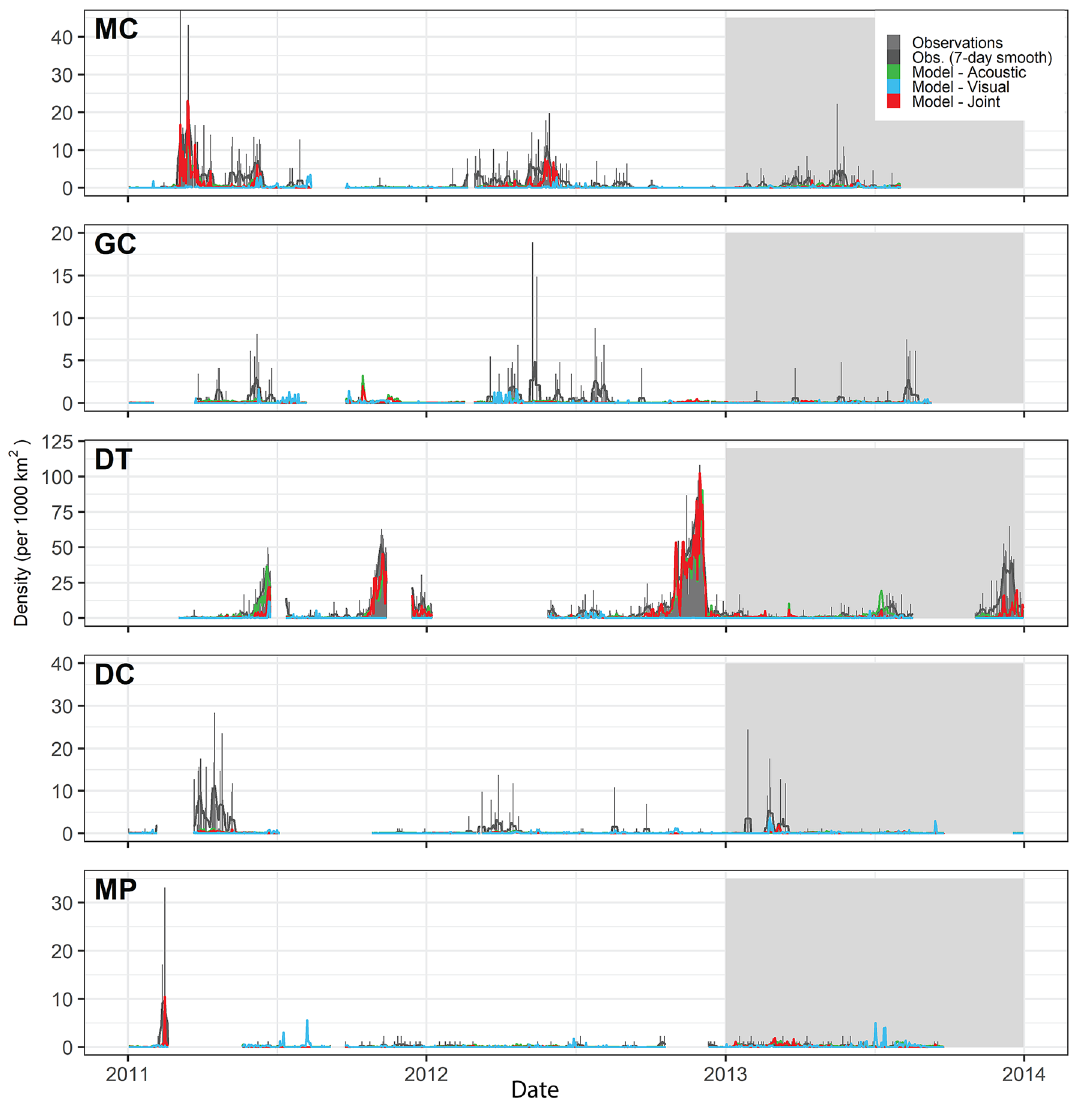
Figure 10. Time series of daily observed and neural network model-predicted Risso’s dolphin densities from the passive acoustic monitoring sites. Markings as in Fig.